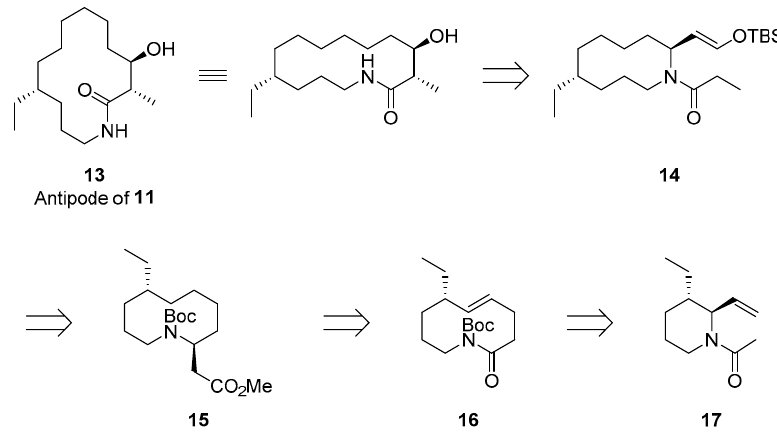
Scheme 1. Retrosynthetic analysis for synthesis of 13 as an antipode of 11